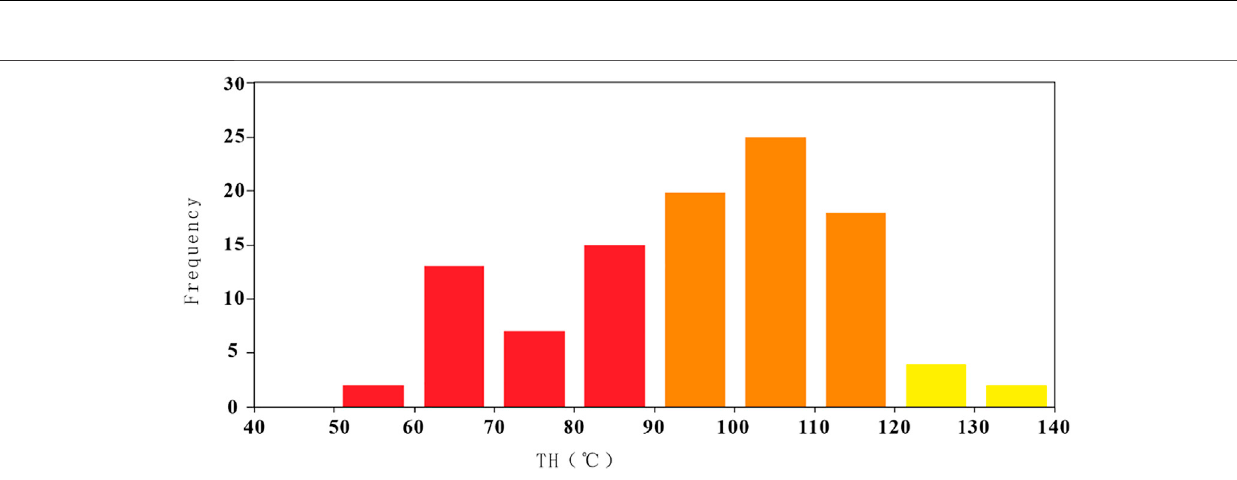
Frontiers in Earth Science |